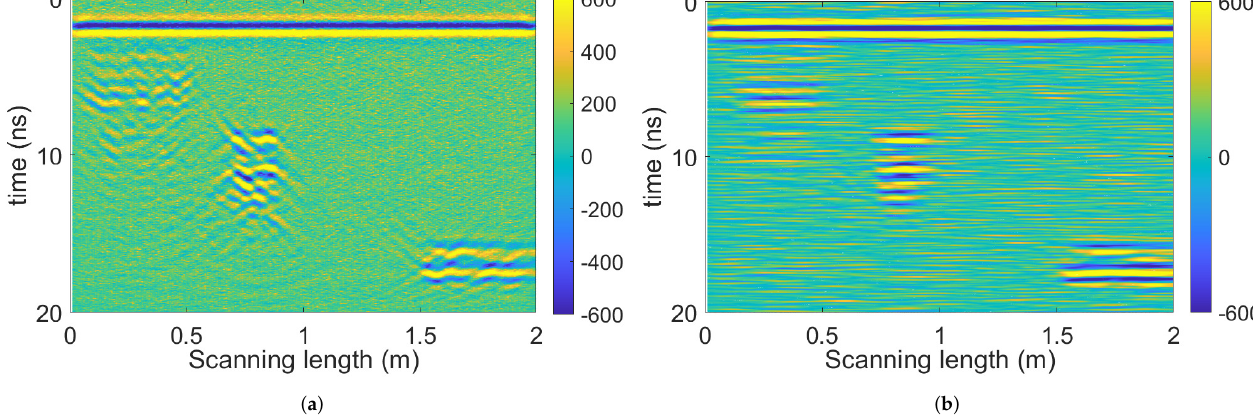
Figure 15. F-K migration results of ( a ) the polluted radargram and ( b ) the 4th-layer DH 4